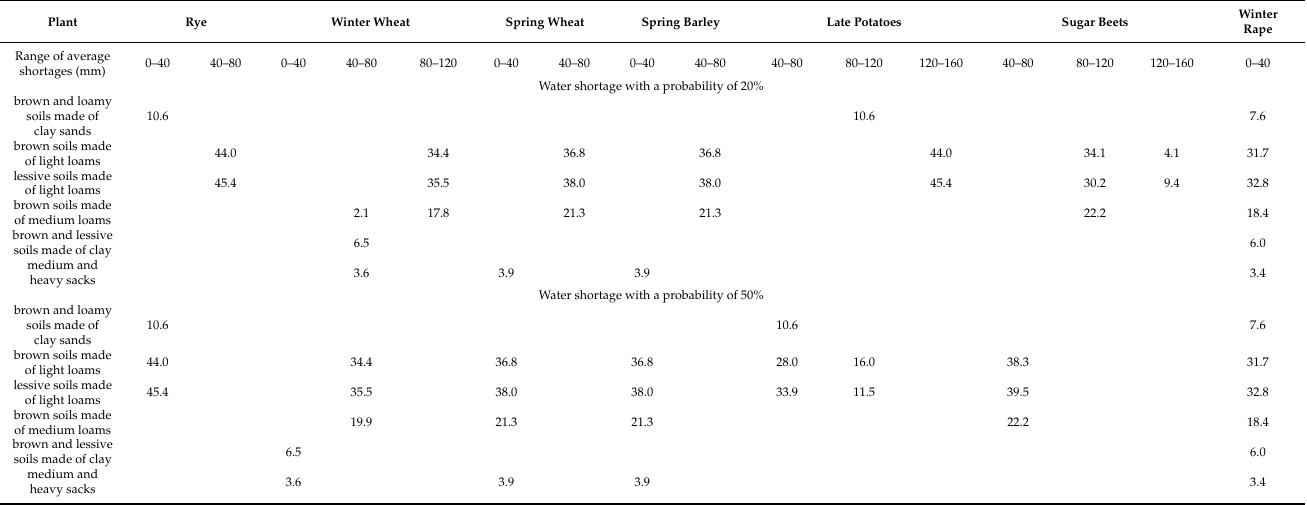
Table 2. Percentage share of soil type in the area of crops potentially affected by water shortages, with a probability of 20% and 50%, in Braniewo poviat